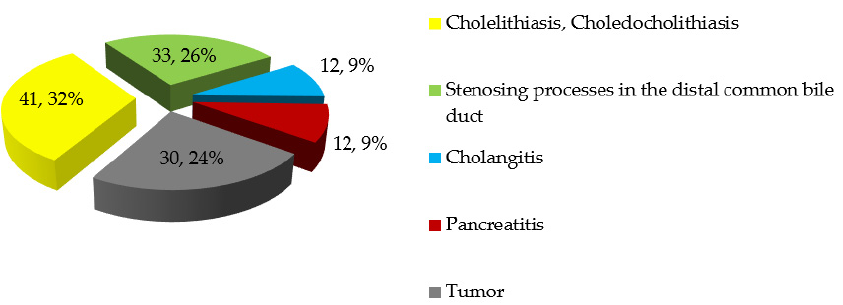
Figure 1. Distribution of patients by the pathologies responsible for the development of obstructive jaundice (abs, %).